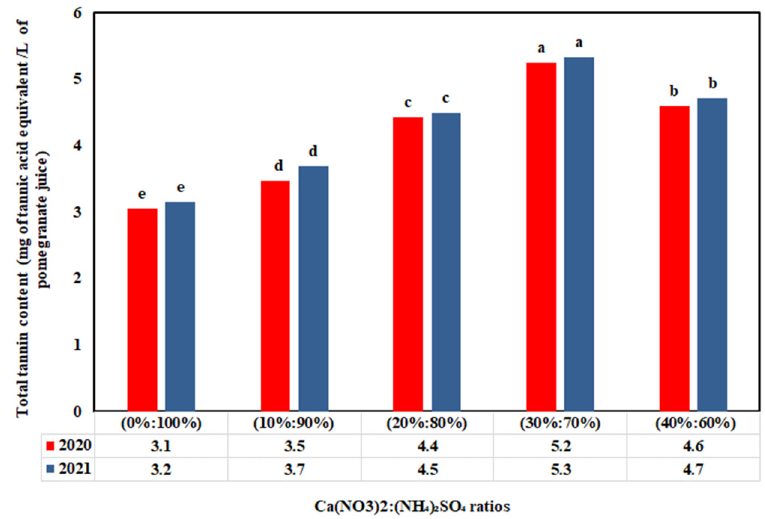
Figure 5. The impact of Ca(NO 3 ) 2 :(NH 4 ) 2 SO 4 ratios on total tannin content of the pomegranate fruits of cv. ‘Wonderful’ in 2020 and 2021 seasons. Significant differences ( p < 0.05) are denoted by values in the same column that are marked with distinct letters.